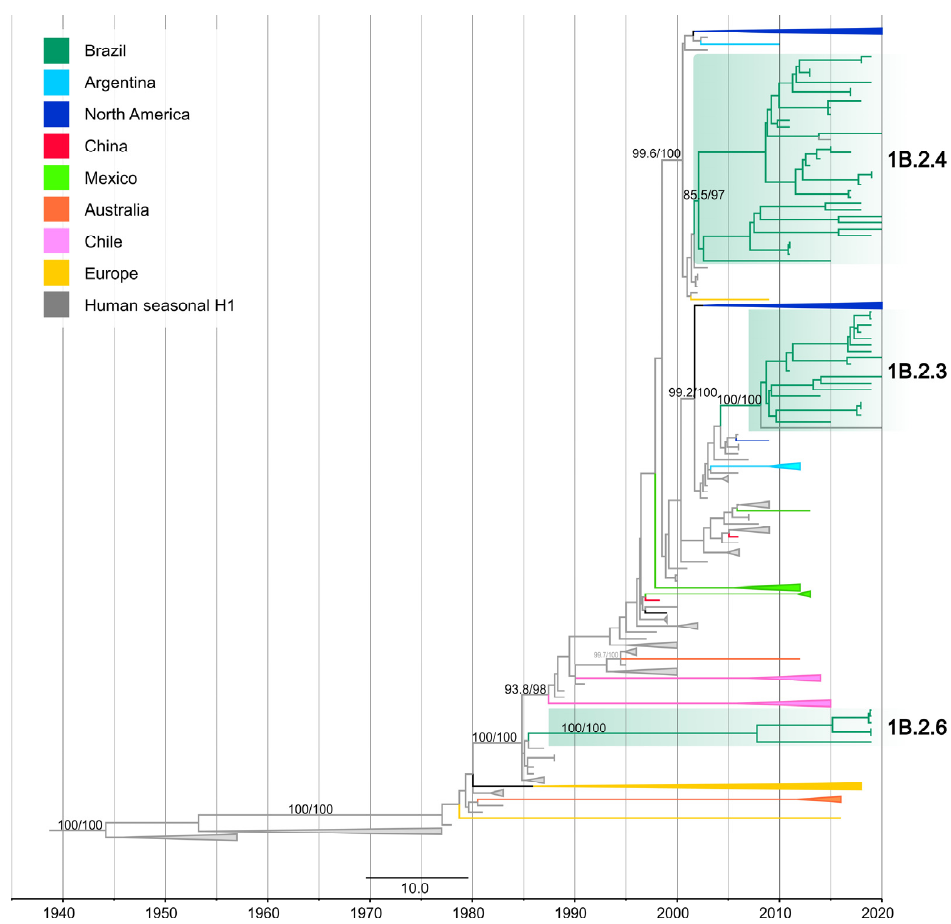
Figure 2. Time-scaled phylogeny demonstrating time of spillover of human seasonal H1 HA gene segments into swine in Brazil. Phylogenetic relationships of the H1 sequences from 414 human-origin H1N2 and H1N1 swine influenza virus isolates collected globally during 1939–2020, and 98 human seasonal H1N2 and H1N1 influenza viruses collected globally from humans during 1939–2020 (total dataset, n = 512 H1 sequences). Gray branches indicate human seasonal influenza viruses. The three clades of Brazilian swine viruses are highlighted in green (Table S2). Branches associated with viruses from swine are shaded by country of origin. Branch support values (aLRT/UF boot) > 85 are provided for key nodes.